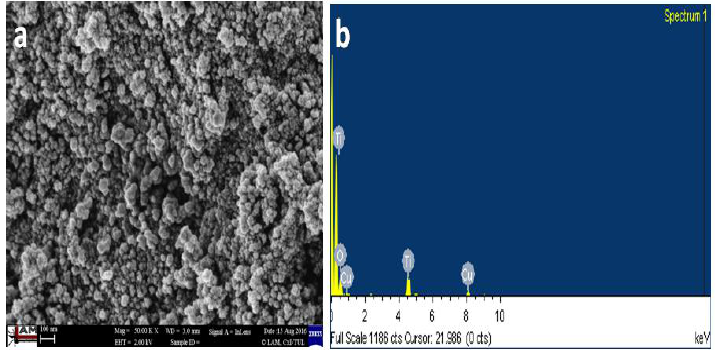
Figure 5. Typical ( a ) scanning electron microscopy (SEM) and ( b ) EDX (Energy Dispersive X-Ray) analysis of TiO 2 nanoparticles.